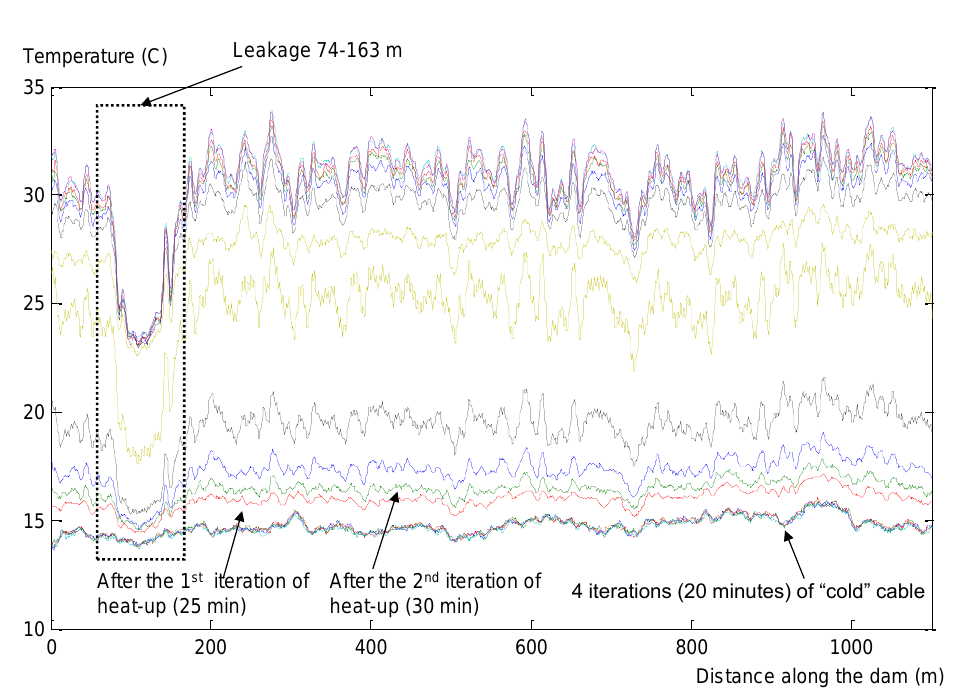
Figure 17. Retaining dam GTC Kappelmeyer fibre optic cable heat-up in time: X axis—length of the cable (m), Y axis—temperature (Celsius). The colours indicate different